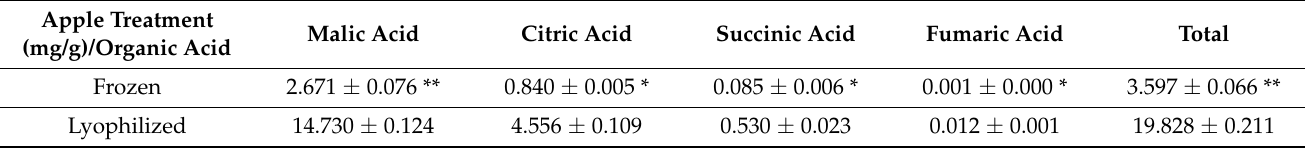
Table 1. Content of organic acids in AP samples, expressed in mg/g.